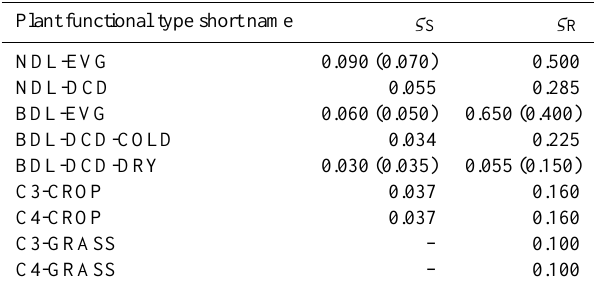
Table A2. PFT-specific base respiration rates (kgC ( kgC ) − 1 yr − 1 ) for the stem ( ς S ) and root ( ς R ) components (Eq. A25) used in the autotrophic respiration module of CTEM v. 2.0. Some parameter values differ between the model versions when PFTs’ fractional coverage is specified and when they are dynamically modelled us- ing competition between PFTs. If modified, the parameter values for the dynamically modelled version are shown in parentheses.